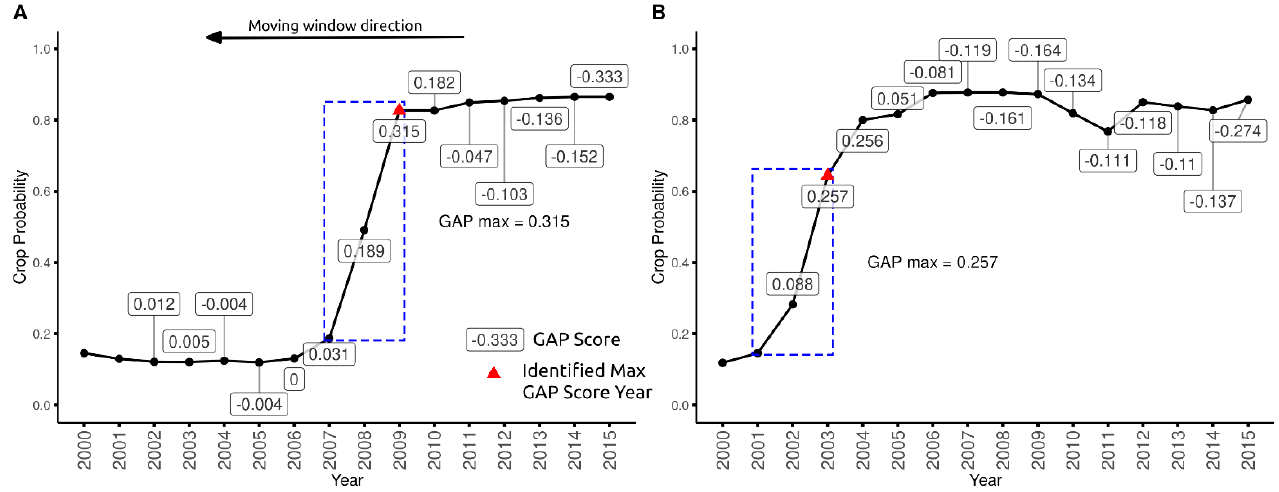
Figure 4. The identified shapelet (blue box) for two cropland gain examples. The GAP score was labeled for each point and the point of max GAP score was labeled with a red triangle for 2009 ( A ) and 2003 ( B ). Note the moving window starts from 2015 and moves towards 2000, following the same direction as the BULC – U update, but for clarity the x – axis starts in the year 2000.